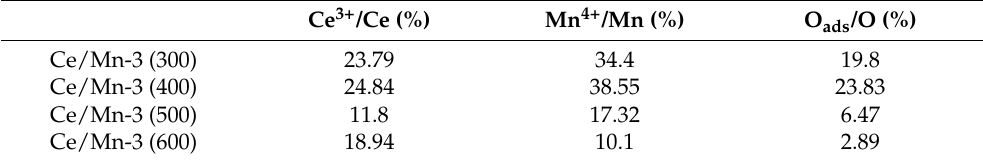
Table 1. The calculated ratios of Ce 3+ , Mn 4+ , and O ads in different catalysts based on XPS analysis.